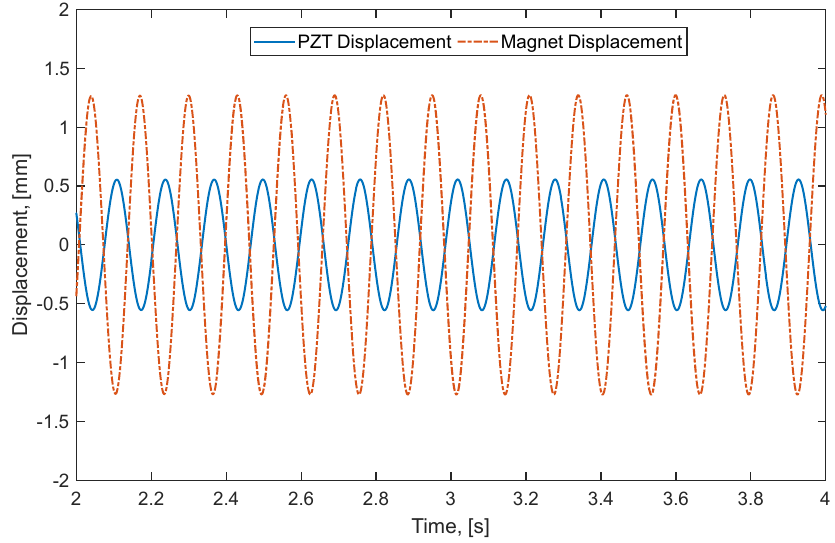
Figure 18. The steady-state time histories of the PZT beam tip and magnet displacements at a wind speed of 2 m/s at an optimum number of turns ( 𝑁 (cid:3030) = 222).